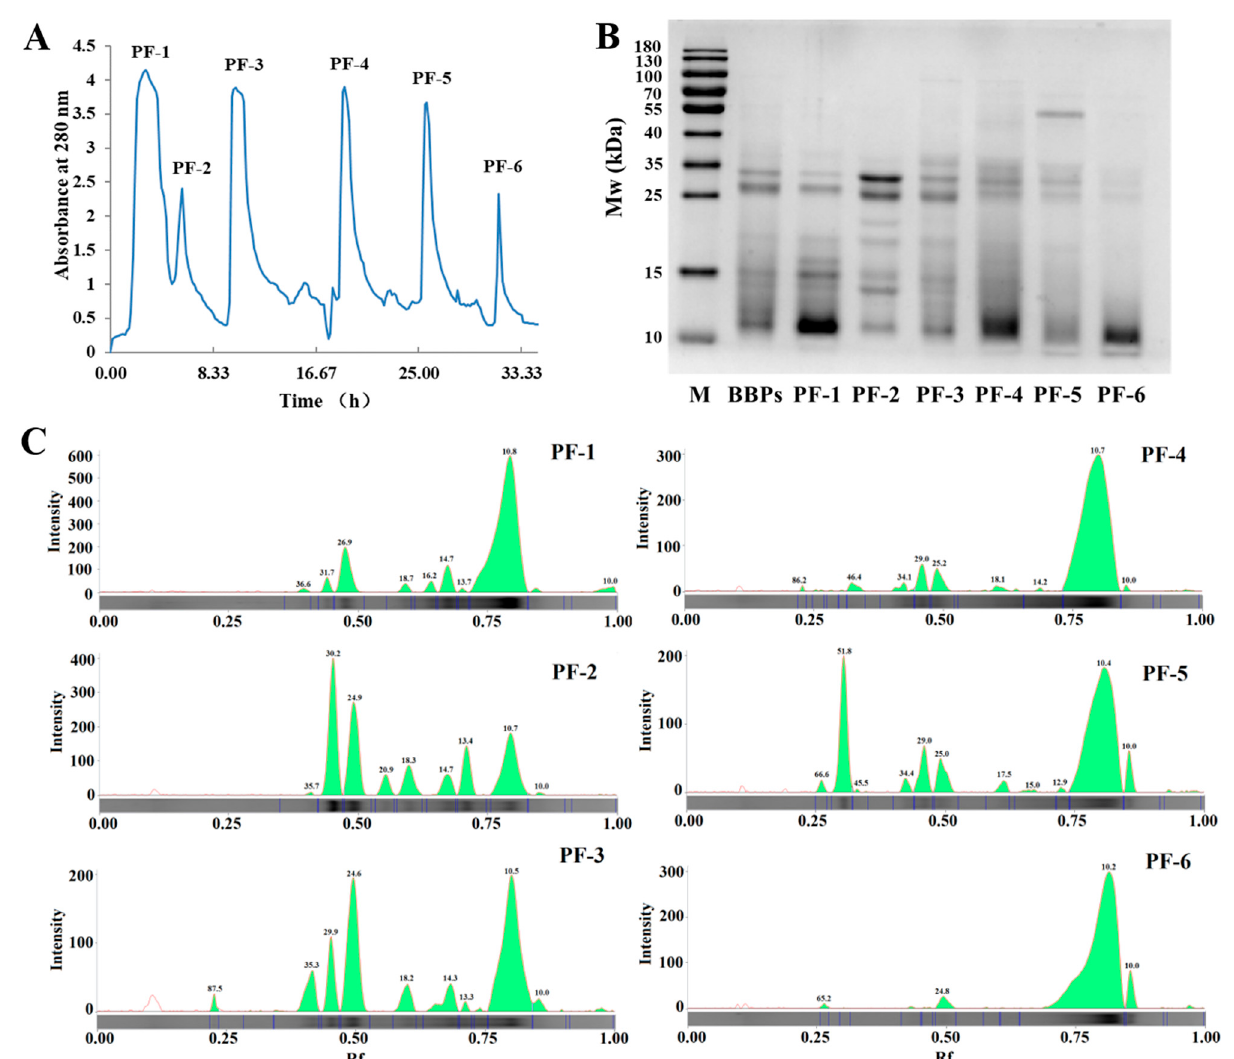
Figure 1. DEAE-52 Sepharose FF chromatographic diagram ( A ), SDS-PAGE analysis of six subfrac- tions ( B ), and electrophoresis lane profile for each subfraction ( C ). BBPs: Total proteins from Bombyx batryticatus ; M: Protein Markers. Table 1. The molecular weight and relative quantification of Markers, BBPs, PF-1, PF-2, PF-3, PF-4, PF-5 and PF-6.